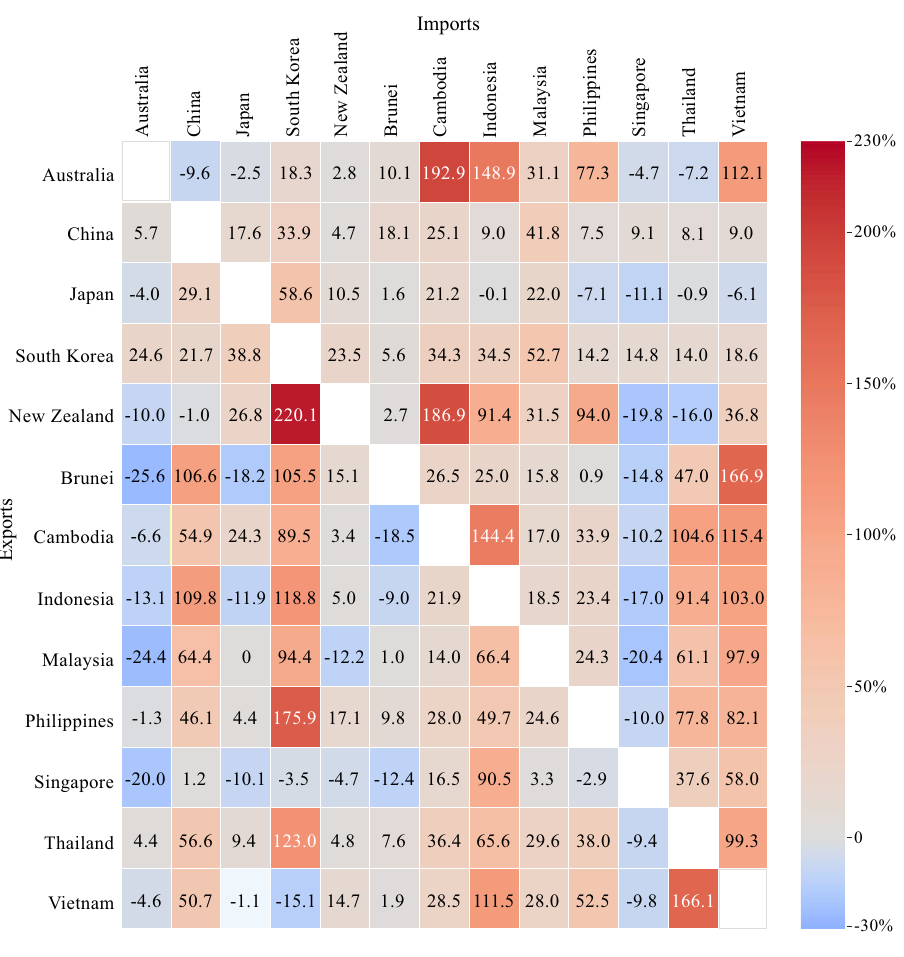
Fig. 1 Trade effects of the RCEP tariff elimination on member countries (%). The fi gure presents the change rates in multilateral trade for the situation in which trade in goods among the Regional Comprehensive Economic Partnership (RCEP) members has zero tariffs. Two ASEAN (Association of Southeast Asian Nations) countries (Laos and Myanmar) are classi fi ed into the rest of the world because input – output tables for Laos and Myanmar are not available. We thus cannot provide results for these two countries. According to the Schedule of Tariff Commitments in the RCEP agreement (Supplementary note 1), most tariff reductions will be implemented within ten years, which implies that most of the impacts will be achieved within ten years. The results for the cases in which the tariffs decline to the committed level in years 1, 5, 10, and 20 after the RCEP enters into force are provided in Supplementary Tables 4 – 7. The results for any other years are also available upon